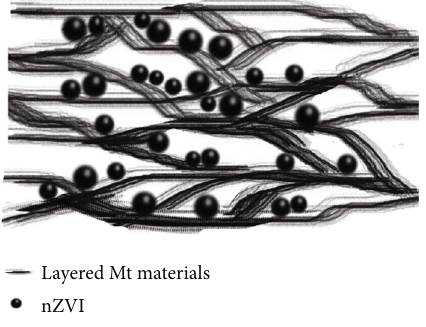
Figure 2: Schematic representation of the sectional structure of Mt-nZVI. Modi fi ed from Wu et al.